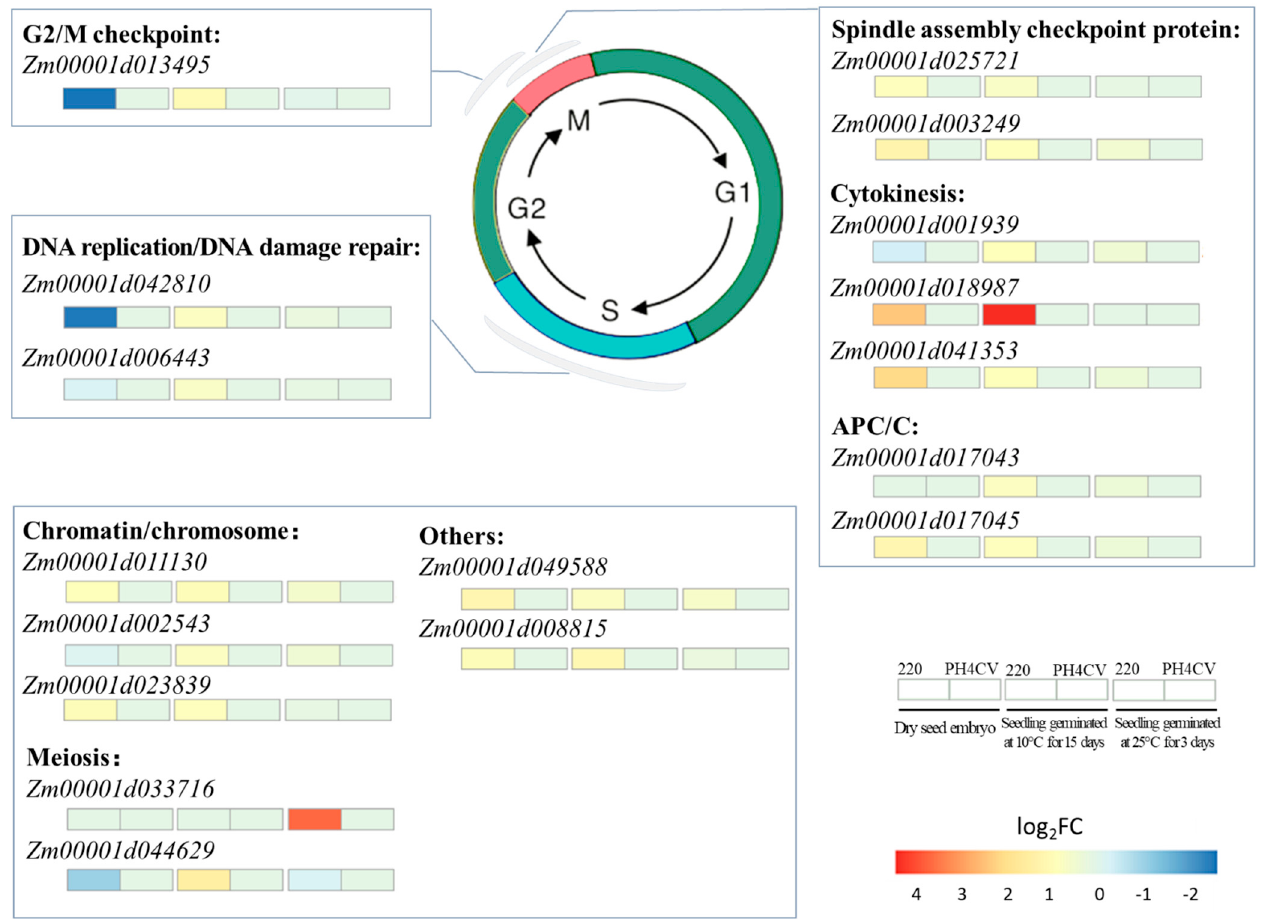
Figure 6. Cell-division-related L220 specifically expressed LTGA DEGs. Red and blue rectangles below the gene name represent up- and downregulated expression in L220 compared with PH4CV.